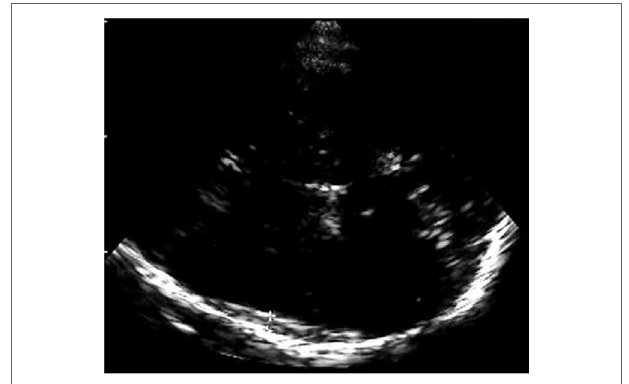
FigUre 1 | Figure shows the highly echogenic skull opposite to the probe and a highly echogenic membrane clearly distinctable from the skull as sonographic correlate of the dural border of the arachnoid and as a sign of subdural space